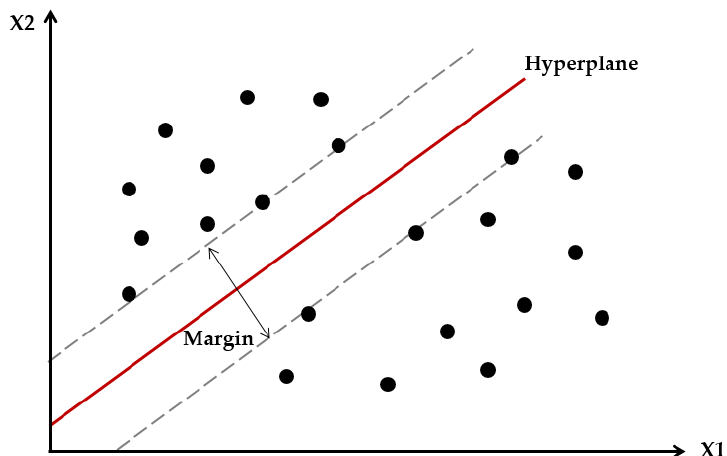
Figure 5. Support vector machine with two